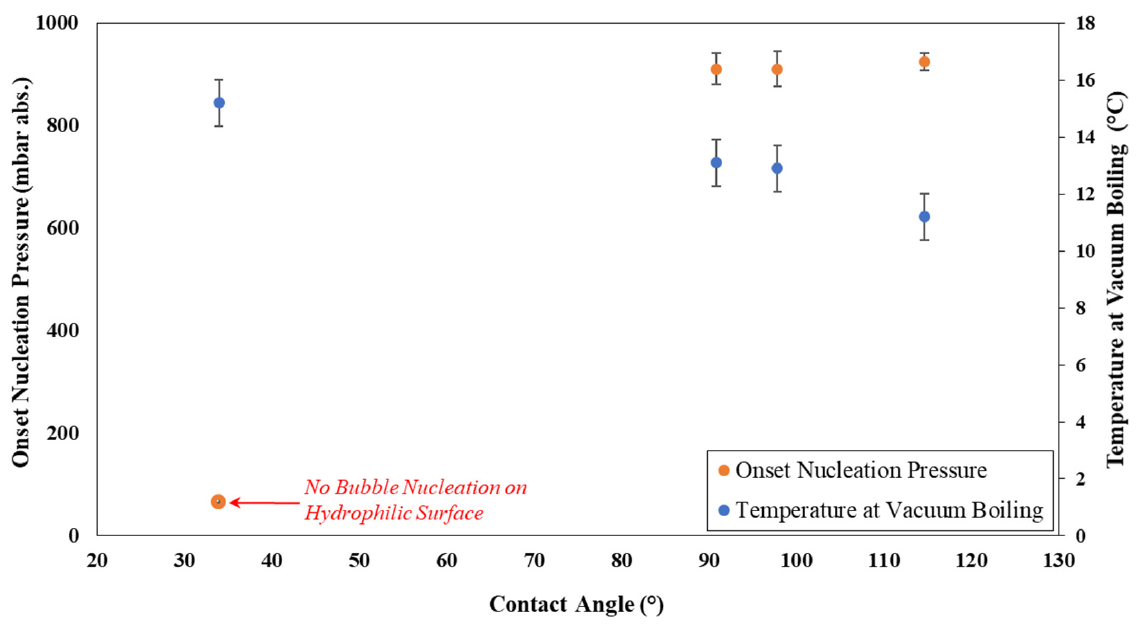
Figure 5. Effect of contact angle on the onset pressure for bubble nucleation, and water temperature during vacuum boiling.